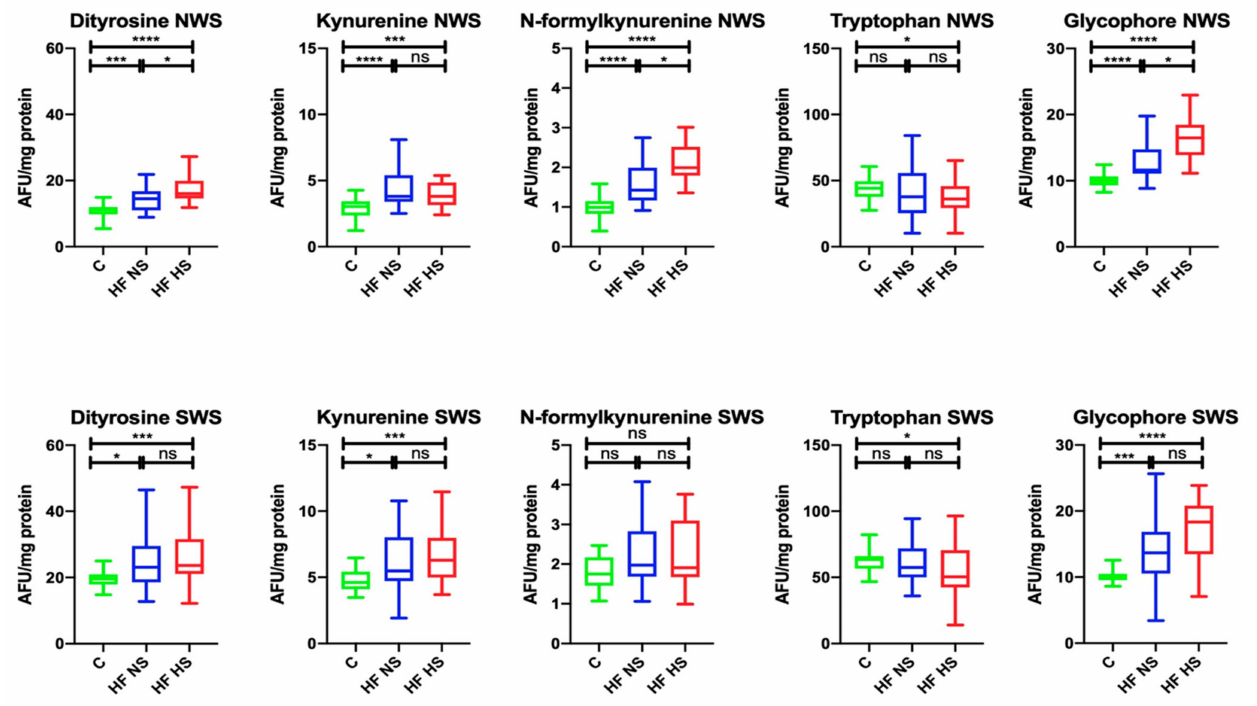
Figure 3. Salivary glycoxidation product status in non-stimulated and stimulated saliva of HF patients and the control group. Abbreviations: HF NS—heart failure with normal salivation; HF HS—heart failure with hyposalivation; NWS—non- stimulated whole saliva; SWS—stimulated whole saliva; * p < 0.05, *** p < 0.001, and **** p <